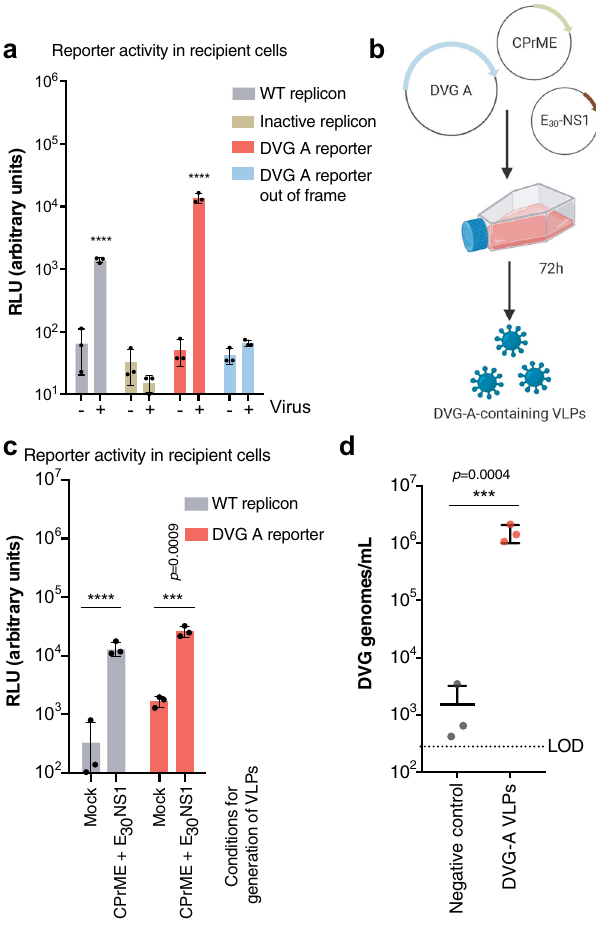
Fig. 4 Generation of DVG-A-carrying virus-like particles. a Assessment of DVG-A packaging ability by WT virus. Infected or uninfected Vero cells were transfected with WT replicon, inactive replicon, DVG-A reporter, or DVG-A out-of-frame reporter RNA. 48 h post-transfection, the cell supernatant was collected from donor cells, depleted of naked RNA, and used to infect naïve recipient cells, which were harvested 24 h later for measuring reporter activity. Luciferase activity in recipient cells is shown. **** p ≤ 0.0001 (by two-way ANOVA with Dunnet ’ s multiple comparison, as compared to uninfected cells). b Schematic illustration of VLP assays: HEK-293T cells were transfected with a CPrME, E 30 -NS1 and DVG -encoding plasmids. 72 h post-transfection the cell culture supernatant with DVG-containing VLPs was harvested. c VLP assays using WT replicon and DVG-A reporter. Donor HEK-293T cells were transfected with WT replicon or DVG-A reporter plasmid, with or without (mock) CPrME and E 30 -NS1. The cell culture supernatant was treated with nuclease and used to infect naïve recipient Vero cells. Reporter activity in recipient cells is shown. **** p ≤ 0.0001 (by two-way ANOVA with Dunnet ’ s multiple comparison, as compared to mock conditions). d Quanti fi cation of DVG-A genomes in VLPs generated using native DVG-A. Clari fi ed and nuclease-treated supernatant from donor cells were subjected to DVG-A quanti fi cation using RT-qPCR. Negative control refers to supernatant derived from cells transfected with the same amount of DVG-A-containing plasmid in the absence of CPrME or E 30 -NS1. *** p = 0.0004 (by two-tailed t-test). All graphs show the mean and SD; n = 3 per group of a representative experiment out of three. Source data are provided as a Source Data fi